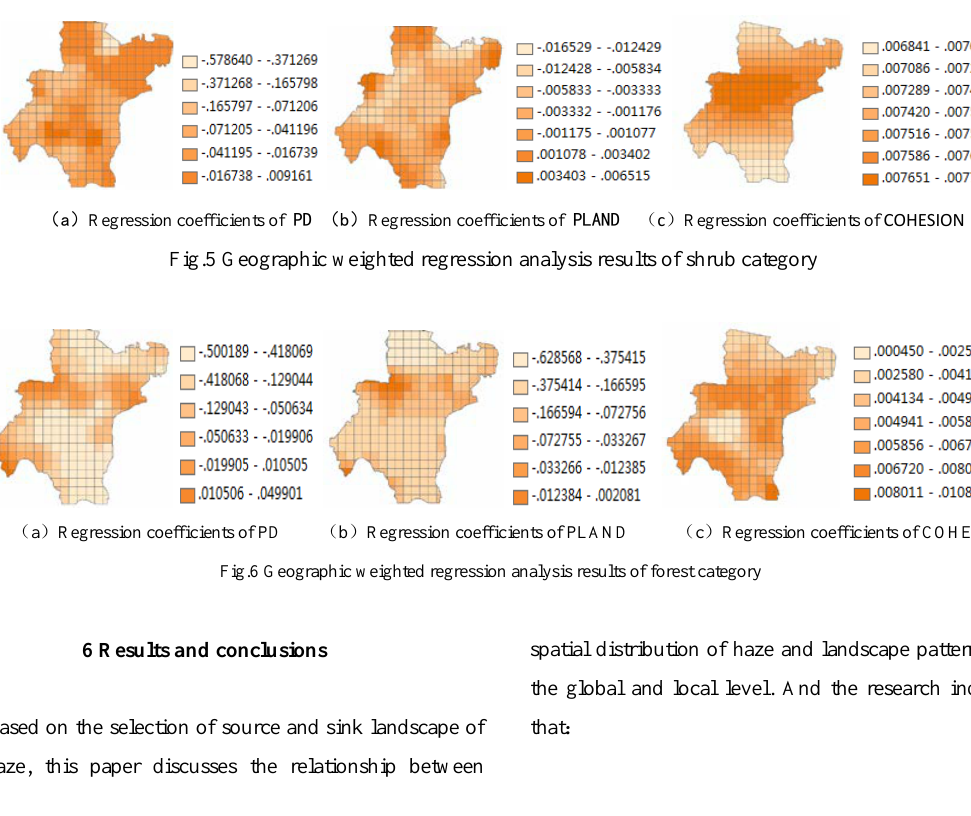
Fig.4 geographical weighted regression analysis results of Building category